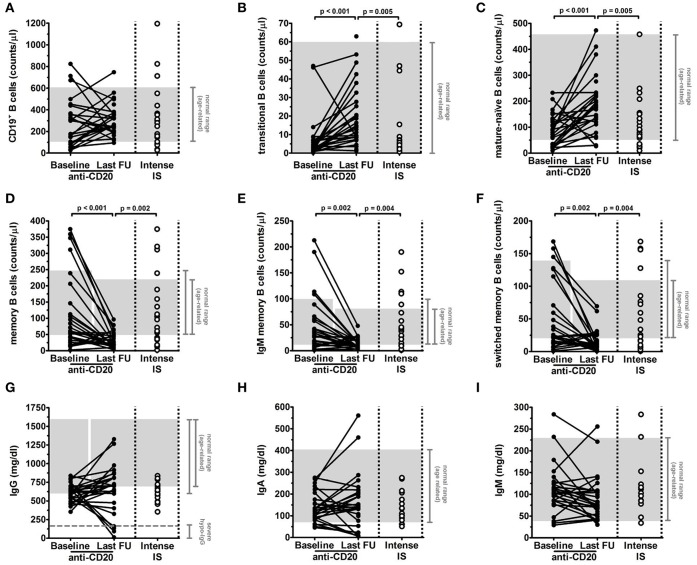
Long-term effects of anti-CD20 treatment on levels of circulating B-cell subsets and total serum immunoglobulins in children with idiopathic nephrotic syndrome (INS). Levels of B-cell subsets (A–F) and of immunoglobulins (G–I) were analyzed in INS pediatric patients (n = 27) before (Baseline) and after more than 4 years from the first and at least 2 years from the last anti-CD20 infusion (Last FU) and in INS patients under an intense oral immunosuppression (Intense IS, n = 21). (A–F) Gated total CD19+ B cells (A) were identified on the basis of the expression of surface markers as previously described (7); (B) transitional, (C) mature-naïve, (D) total memory, (E) IgM memory, and (F) switched memory B cells were expressed as absolute cell count per microliter of blood. (G–I) Levels of total (G) IgG, (H) IgA, and (I) IgM were expressed as mg/dl. Each plot represents a different patient. Gray areas represent the age-related normal range between the 5th and 95th percentiles indicated in Piatosa et al. (15) for the different B-cell subsets and by the diagnostic laboratory of our Institution for immunoglobulins. Levels of severe hypogammaglobulinemia (severe hypo-IgG) were identified by the dashed gray line in (G). Since there is a gap of ≥4 years between baseline and last follow-up as per inclusion criteria, the age-related normal range can be different between the two time-points. Differences between groups were compared using the non-parametric paired Wilcoxon signed-rank test and unpaired Mann-Whitney U test, as appropriate.